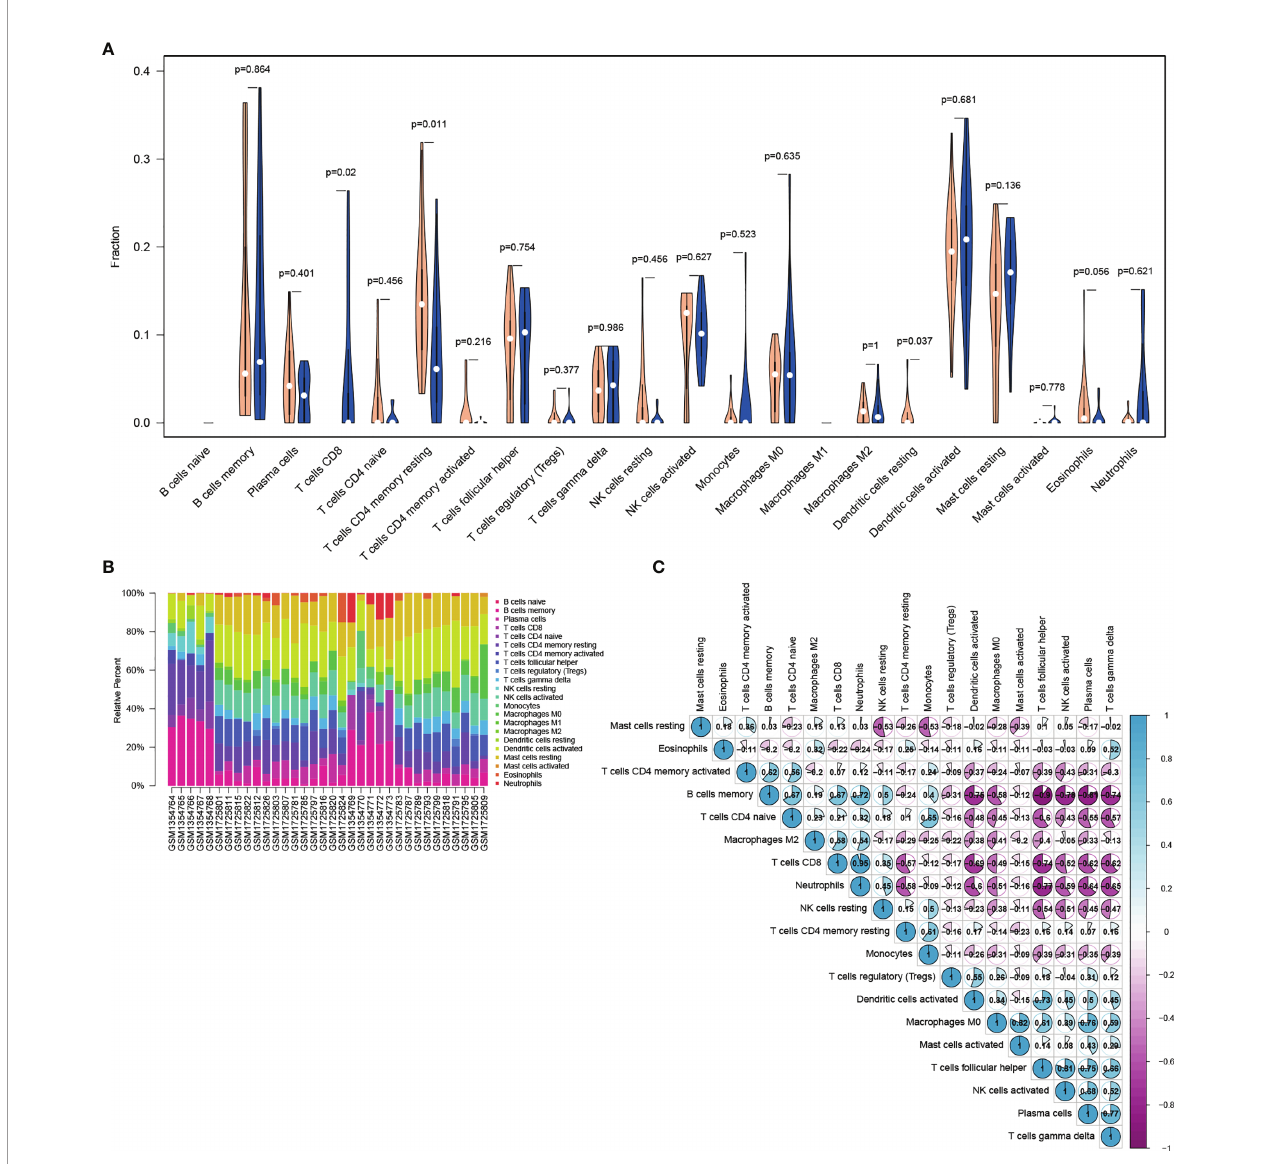
FIGURE 4 | Visualization of immune cell in fi ltration analysis. (A) Violin diagram of the abundance of in fi ltration by 22 immune cell subsets between IDD and control groups. Blue and orange colors represent IDD and control groups, respectively. (B) Histogram of the distribution of in fi ltrating immune cells in each individual. Columns represent IDD individuals. (C) Correlation heatmap of 22 immune cell subsets. Blue represents positive correlation, whereas purple represents negative correlation. The color and number in each circle indicate the correlation index between the two immune cell subsets. IDD, intervertebral disc